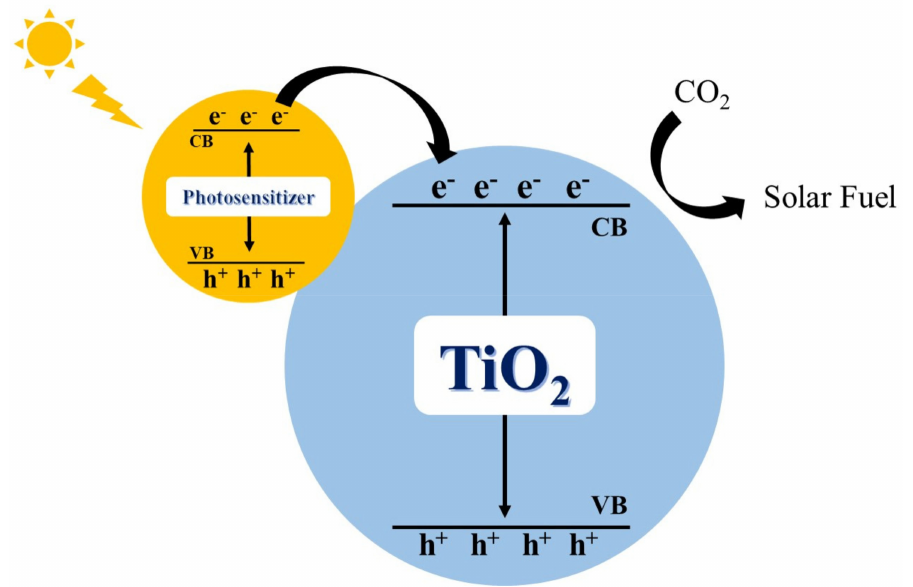
Figure 15. Schematic of the Surface